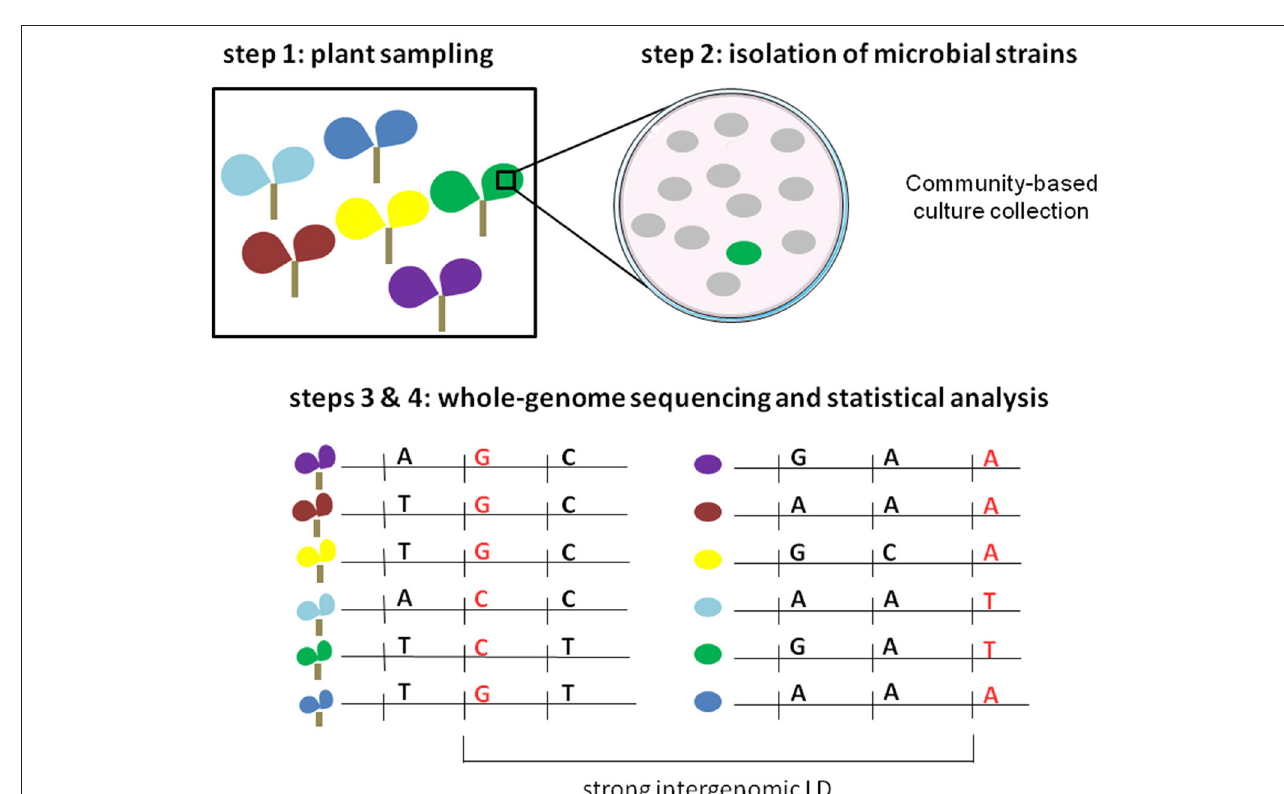
Frontiers in Plant Science |